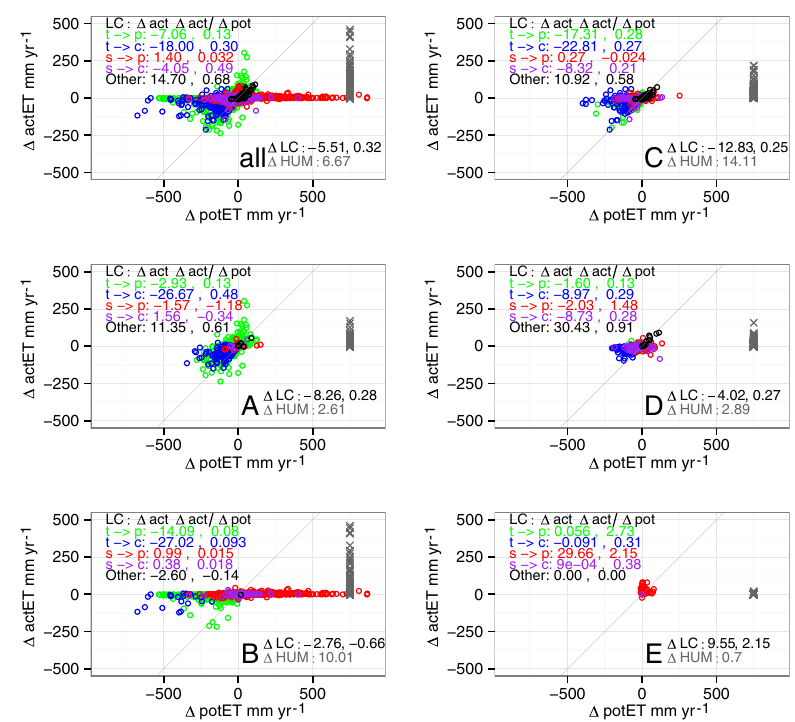
Figure 9. Changes in actual evapotranspiration (actET, y axis) and potential evapotranspiration (potET, x axis) from land per subbasin. Circles represent land cover change (LC2000 − LC1850), and gray crosses represent human water use (HUM200 − LC2000). Note that there is no change in potET between HUM2000 and LC2000; the gray crosses have been moved along the x axis for visibility. Each circle color represents a land cover change: tall to pasture (green), tall to crop (blue), short to pasture (red), short to crop (purple) or other (black, crop or pasture to short or tall natural). The top-left panel represents all subbasins, the other panels represent a Köppen class. A is equatorial, B is arid, C is warm temperate, D is snow and E is polar climates. In each panel the top-left numbers are the average actET change per land cover change and the change in actET divided by the change in potET, in the bottom right are the total land cover changes ( (cid:49) LC, LC2000 − LC1850) as well as the changes due to redistribution ( (cid:49) HUM, HUM2000 − LC2000). No circles are drawn for subbasins where no land cover change occurs. In all panels the 1:1 line is drawn in gray. Note that in some cases the change in actET is larger than the change in potET, or of opposite sign. This generally occurs where changes in potET are small, such as high latitudes or the Amazon or Congo basins. It may also reflect areas where changes in, for example, soil moisture content or rooting depth alters the response to changed potET. Areas and number of subbasins per land cover change are given in Table